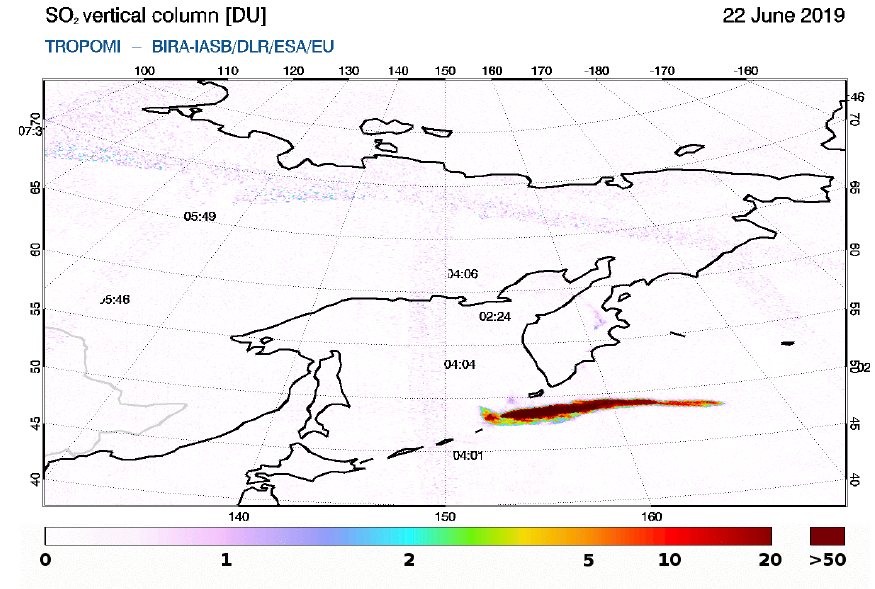
Figure 2. SO 2 detection from TROPOMI on 22 June 2019 (Raikoke eruption, Kuril Islands).